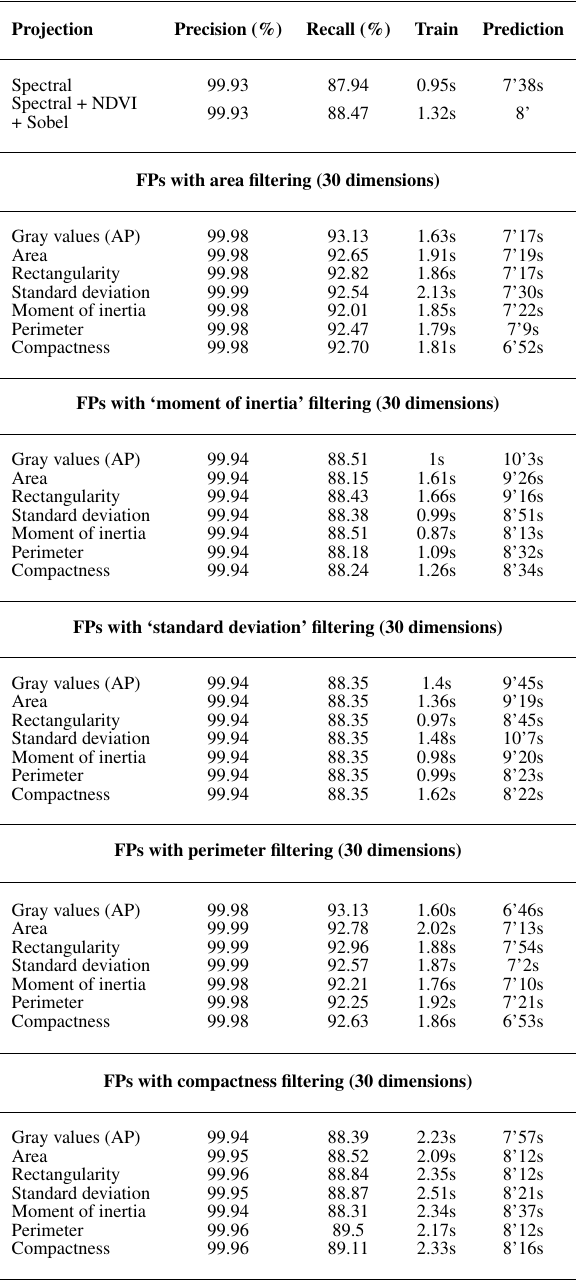
Table 3. Scores and execution times of the SWF classification of the Podgorica data using APs and FPs. Projection Spectral